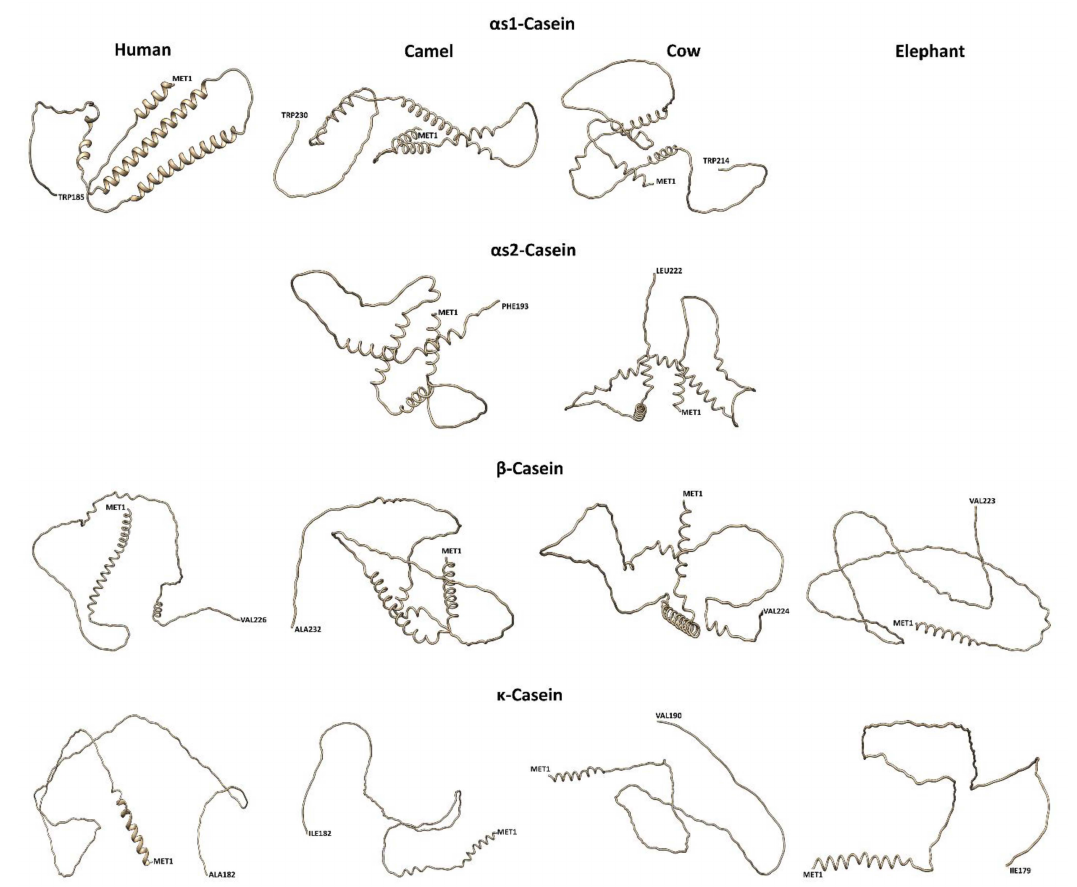
Figure 6. Predicted casein models are visualized using the silhouette and licorice presets of Chimera, using the RaptorX server. As the predicted data is unable to show the real topological scenario and